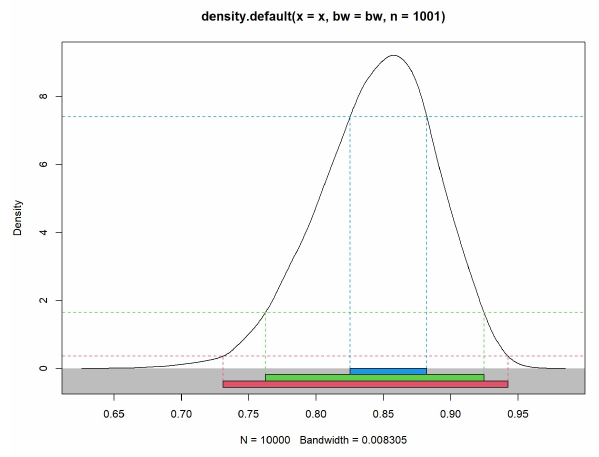
Figure 8. 50% ， 95% ， 99% highest-posterior density of the parameter